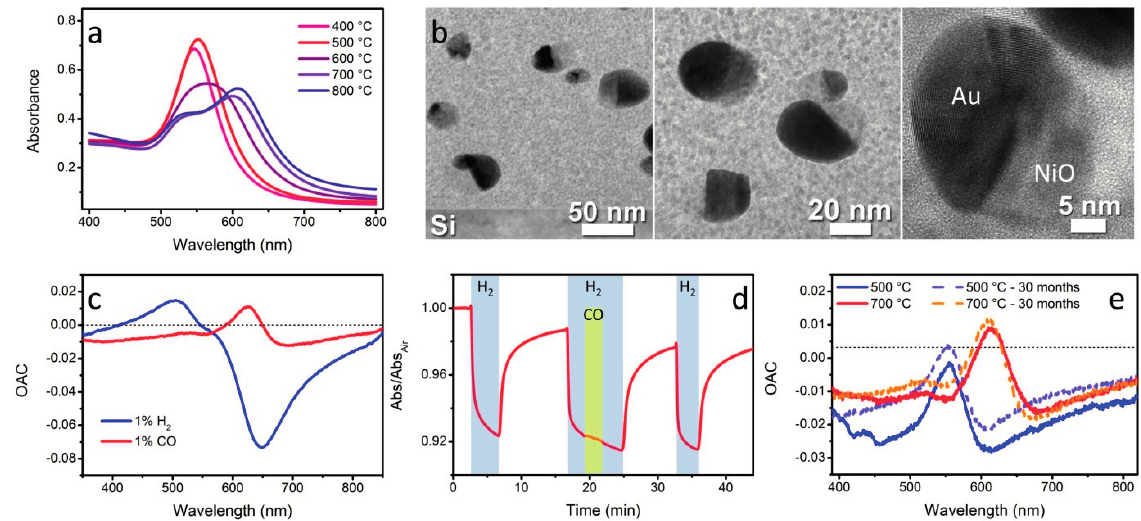
Figure 1. ( a ) Optical absorption spectra of SiO 2 -NiO-Au films annealed at different temperatures. The color of the spectra is representative of the actual color of the samples; ( b ) TEM images at different magnifications of SiO 2 -NiO-Au films showing the cookie-like nanostructures; ( c ) Optical absorption change (OAC) plot of SiO 2 -NiO-Au films exposed to hydrogen and CO at 300 °C showing the wavelength dependent response; ( d ) Time resolved tests of a SiO 2 -NiO-Au film at 300 °C showing selectivity for H 2 even when the sensor is concurrently exposed to interfering CO ( λ = 640 nm); ( e ) OAC plots of SiO 2 -NiO-Au films annealed either at 500 °C or 700 °C and then exposed to 1% CO at 300 °C a few days after being prepared and after 30 months from